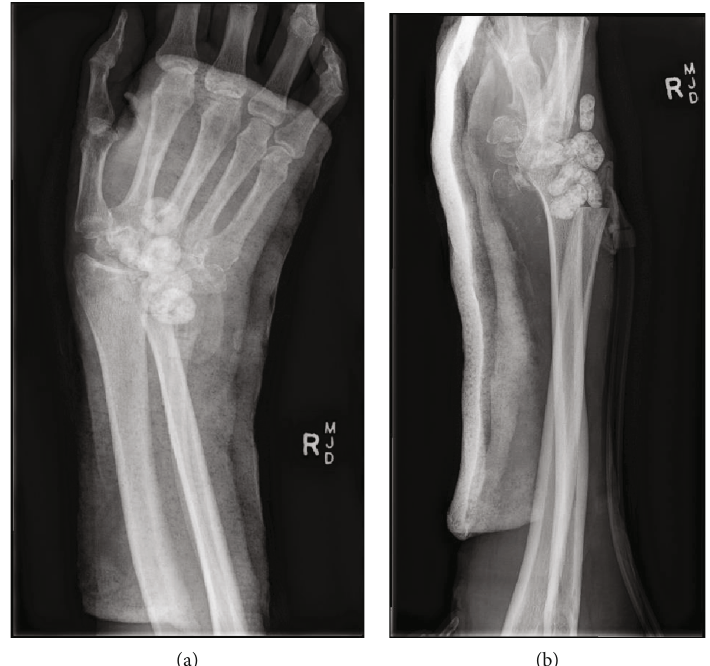
Figure 3: XR of the right hand with voriconazole-impregnated Palacos beads in situ: AP (a) and lateral (b) views. Note the evidence of proximal carpectomy and distal ulnar excision.